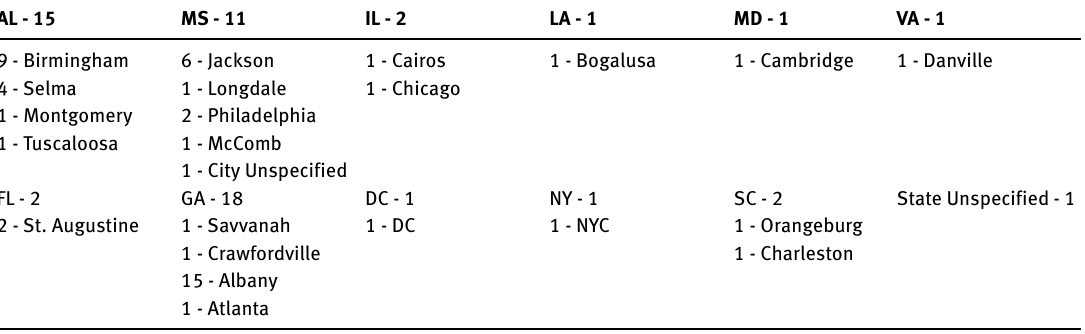
Table 2: Geographic Distribution of Violence-related Public Prayers, 1960-1969 AL -